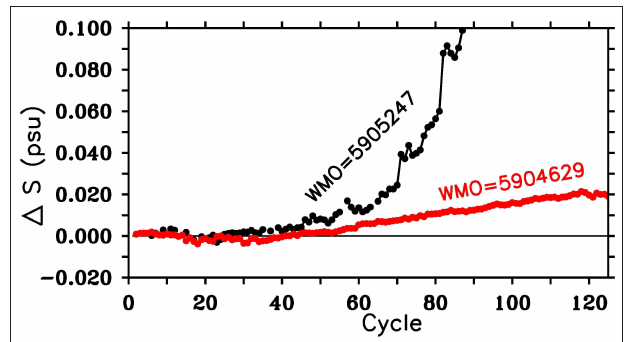
FIGURE 11 | Two examples of SBE CTDs that showed salty sensor drift: a “slow” drift (WMO ID 5904629, in red), and a “fast” drift (WMO ID 5905247, in